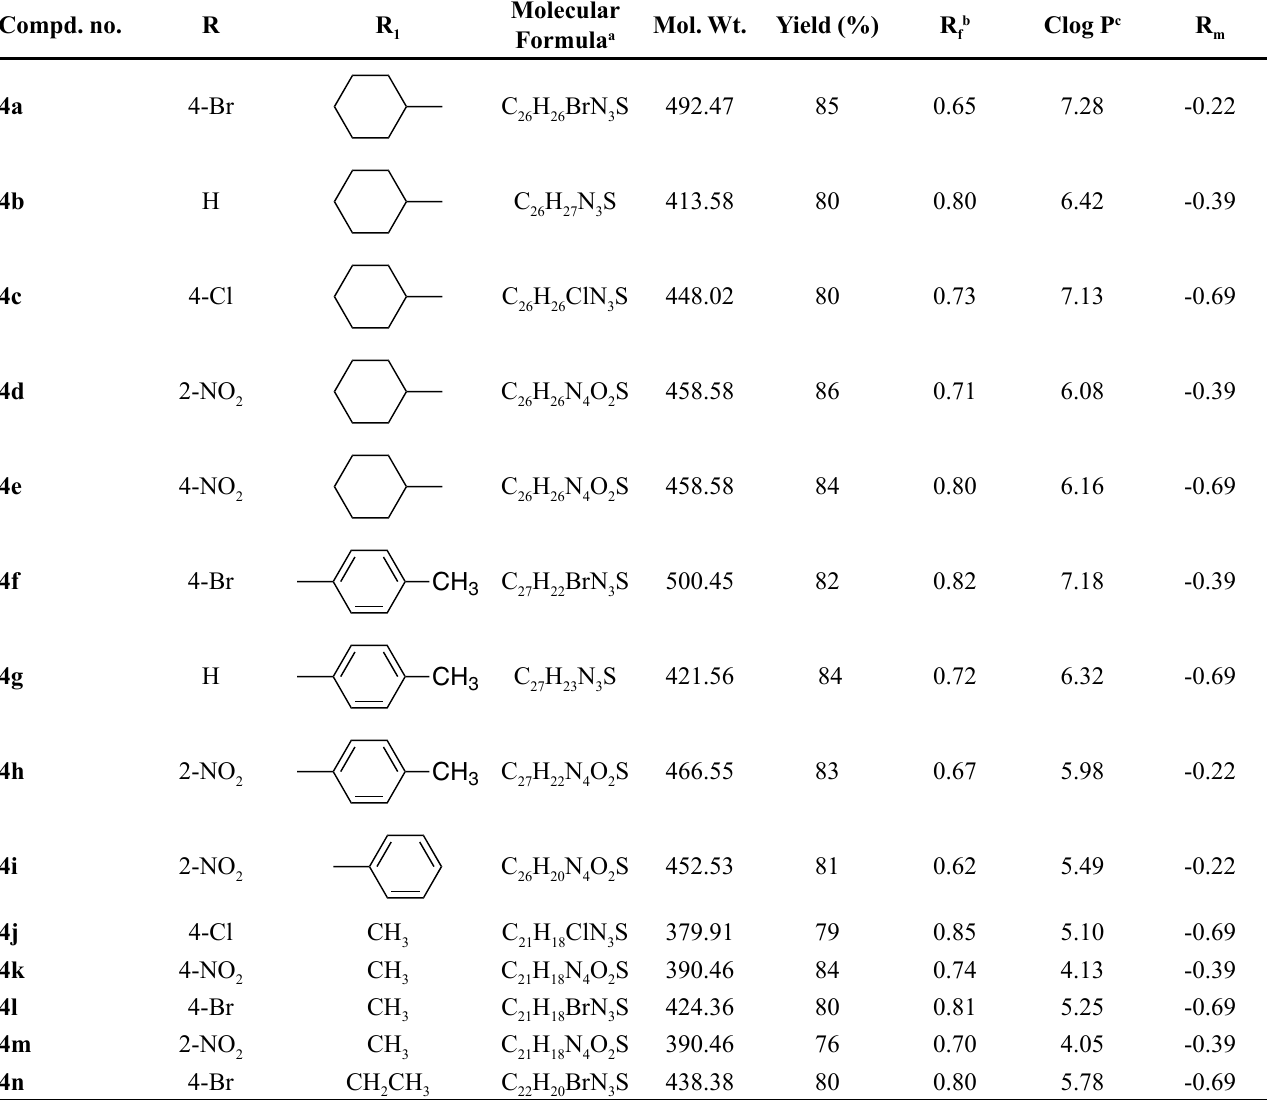
TABLE I - Physicochemical parameters of the synthesized compounds ( 4a - n ) Compd.